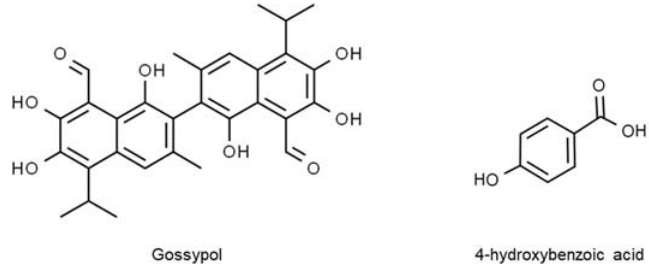
Figure 3. Polyphenolic compounds in cotton seed.